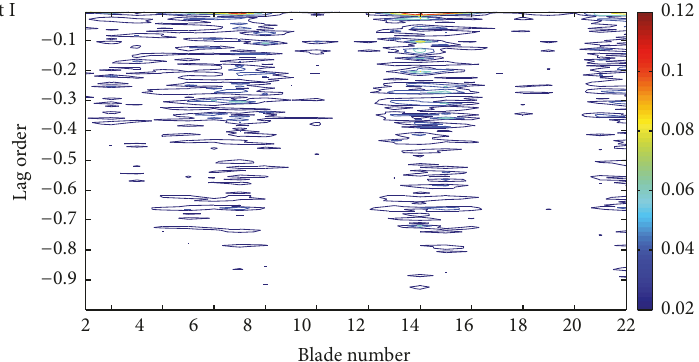
Figure 9: Cross-correlation map for blade 1, event I.